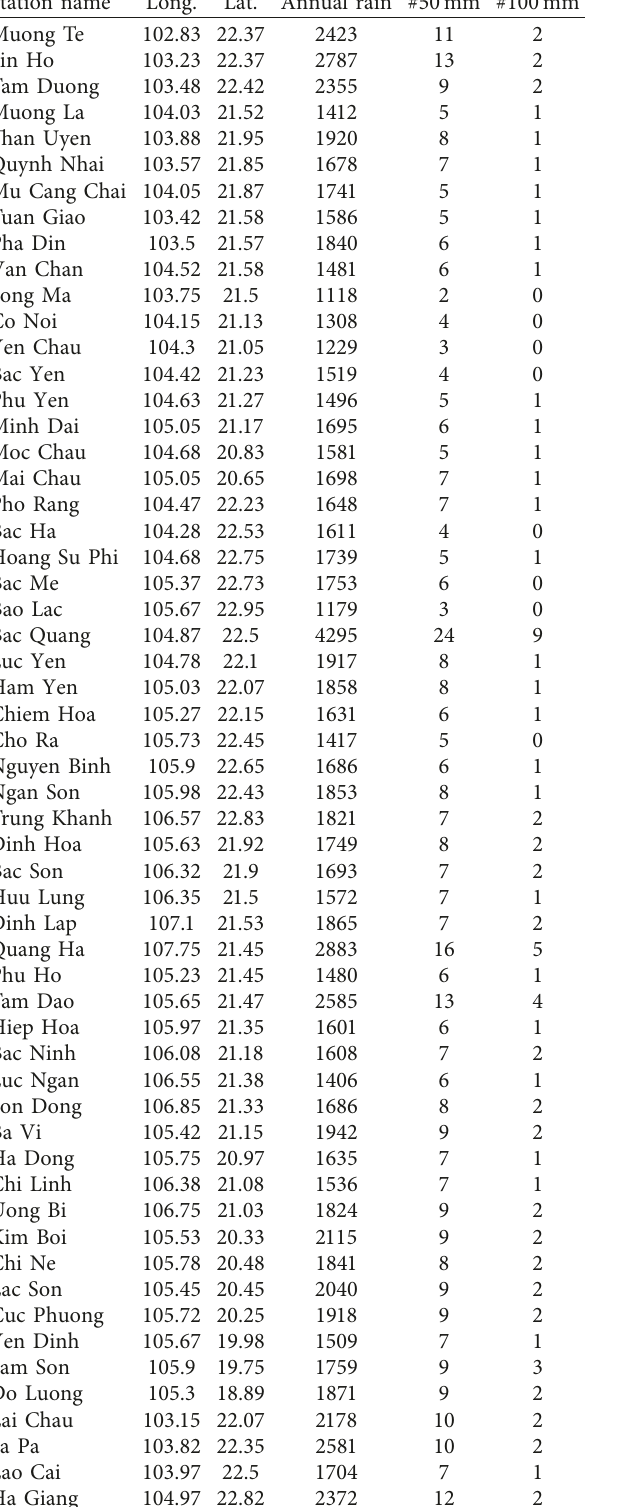
Table 1: Station information over the northern part of Vietnam, annual rainfall (over the period 1998–2018) in mm, and the number of days with daily accumulated rainfall over 50mm/24h (#50 mm) and over 100mm/24h (#100 m) in average. The number of samples is ∼ 7300 each